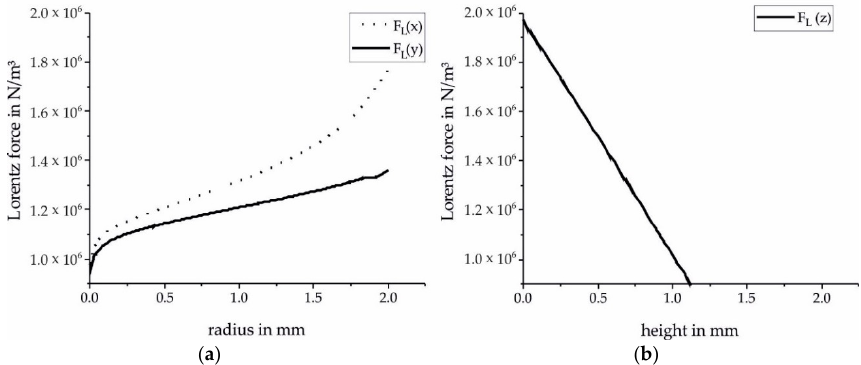
Figure 10. The numerical Lorentz forces in x- and y-directions ( a ) and z-direction ( b ).